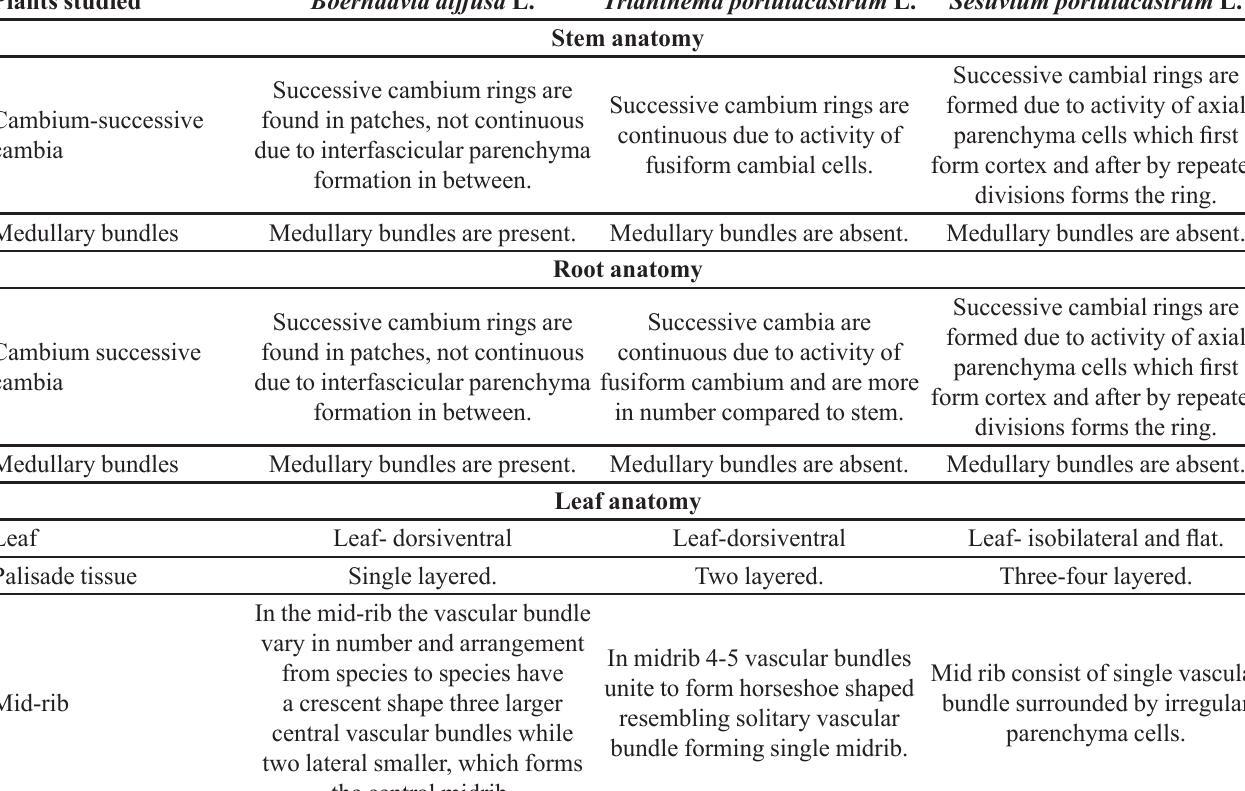
TABLE III - Summery of distinctive anatomical characters of studied plants Plants